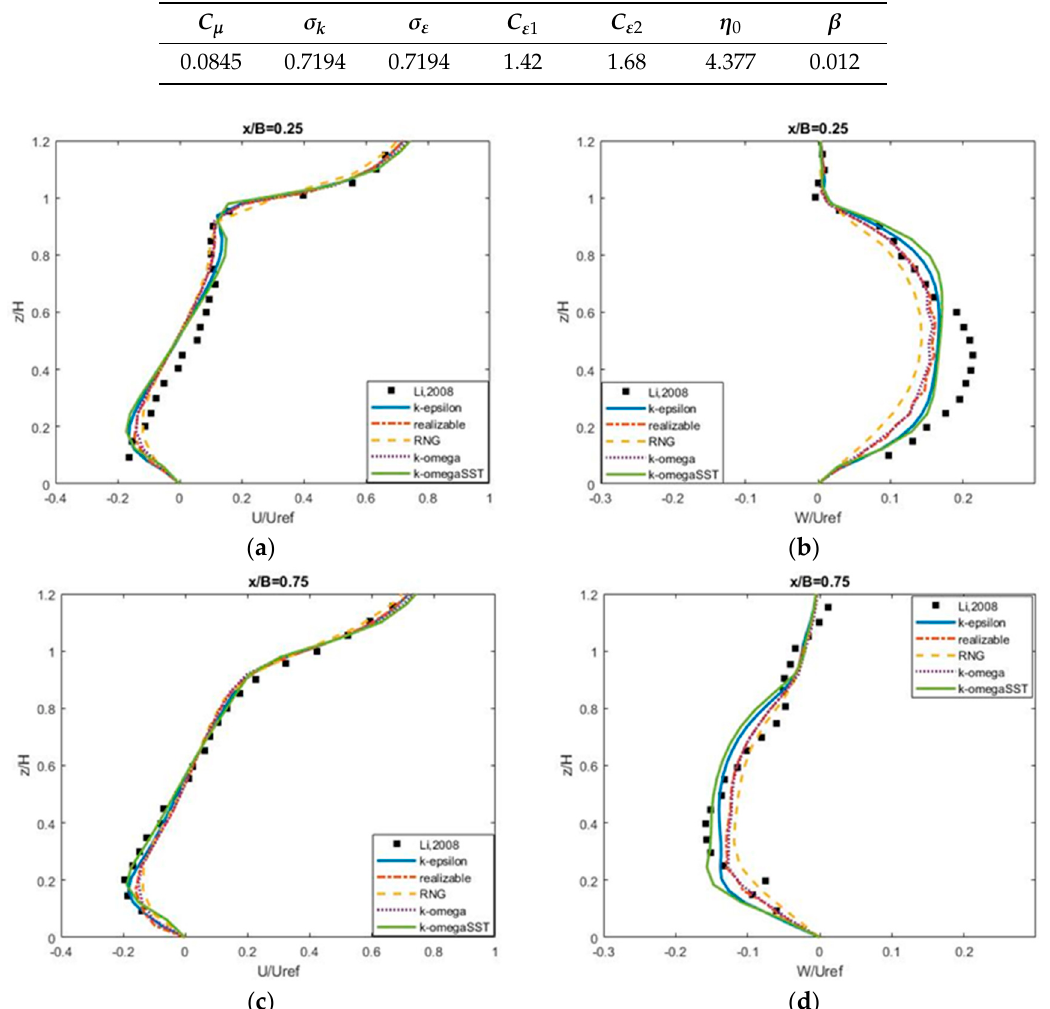
Figure 2. A comparison of dimensionless vertical velocity profiles (U/U ref ( a , c ) and W/U ref ( b , d )) between numerical results obtained from different turbulence models and experimental data (Li et al. [2]). (U and W are mean stream-wise and vertical velocity components, respectively; U ref is free stream velocity at the inlet)